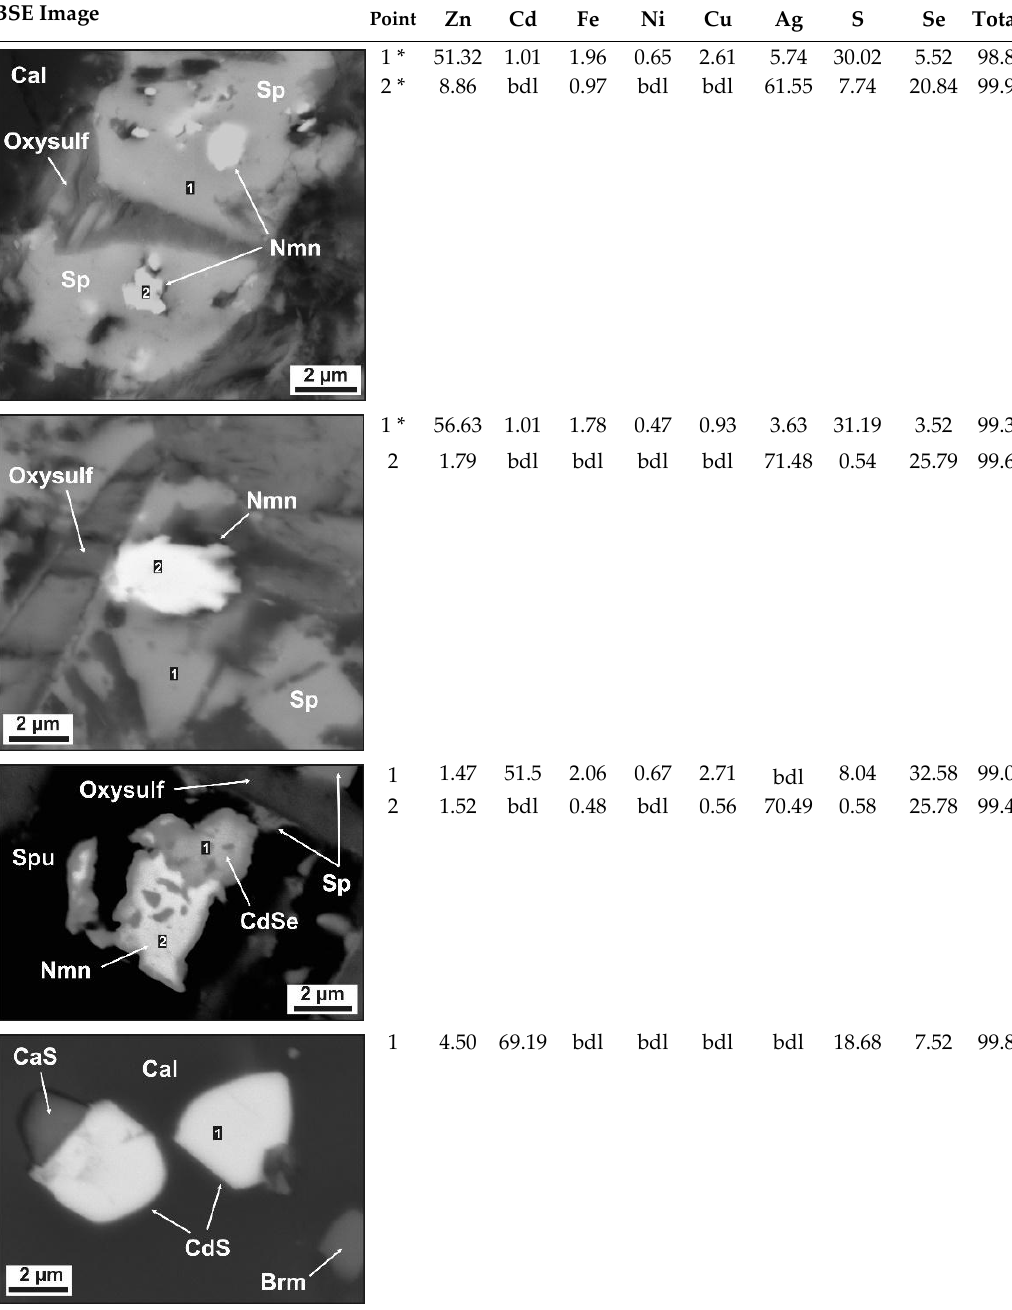
Table 7. BSE images and EDS compositions (wt%) of Zn-, Cd-sulfides, and Ag-, Cd-selenides from the sample DT-25.